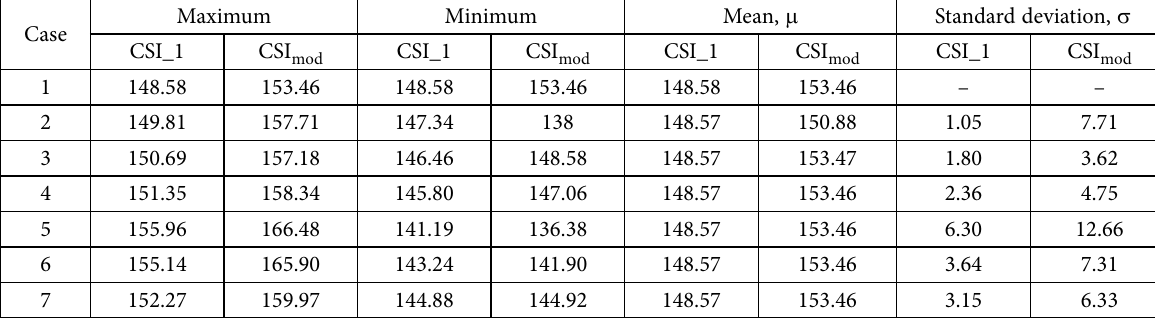
Fig. CSI_1 and C mod distribution (A_max CSI_1 value = 155.96 with overall satisfaction; B_min CSI_1 value = 141.19 with safe delivery; C_max C mod value = 166.48 with overall satisfaction; D_min C mod value = 135.26 with fixed delivery Table 5. Maximum, minimum, mean and standard deviation for both methods (results are shown per